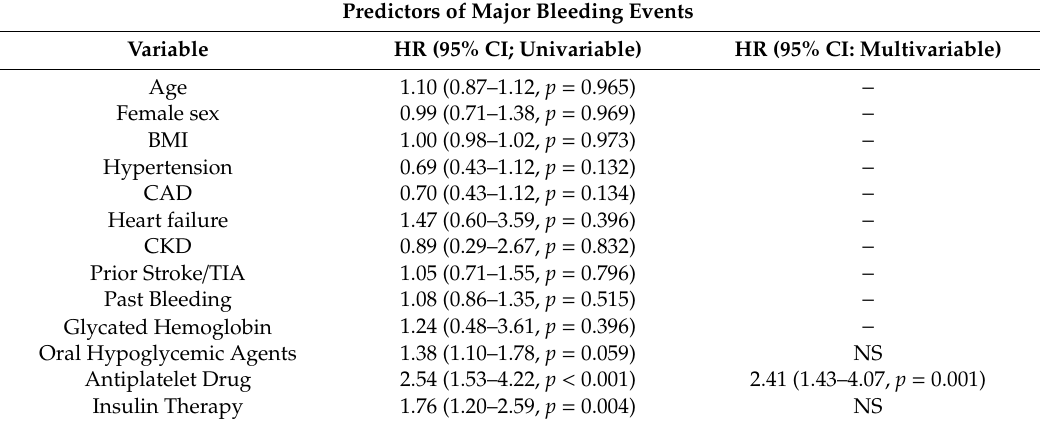
Table 2. Univariate and multivariate analysis results for variables determining the development of major bleeding events.